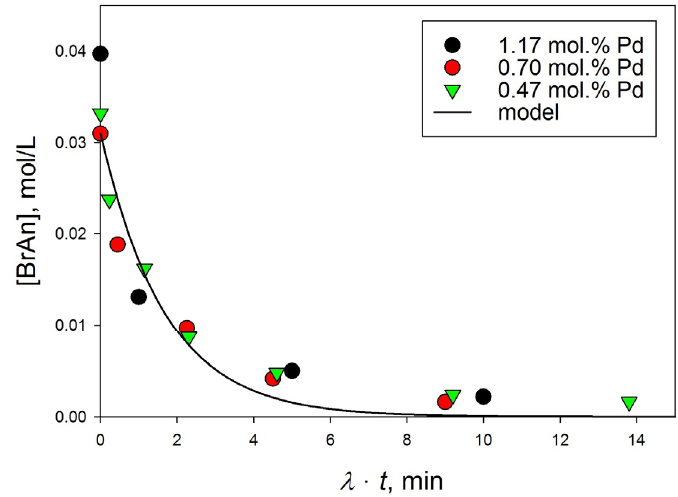
Figure 5. Dependence of the current concentration of BrAn on “conditional” reaction time in a series of experiments with different amounts of Pd(0)/HPS catalyst (black circle—1.17 mol.%, red circle—0.70 mol.%, green triangle—0.47 mol.%); the line is the calculated curve according to the model (see Section 3.3.5).